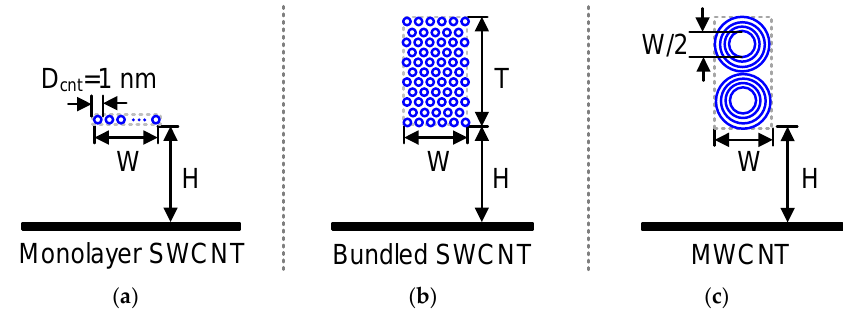
Figure 9. Cross-sectional views of ( a ) monolayer SWCNT, ( b ) bundled SWCNT, and ( c ) MWCNT interconnects.